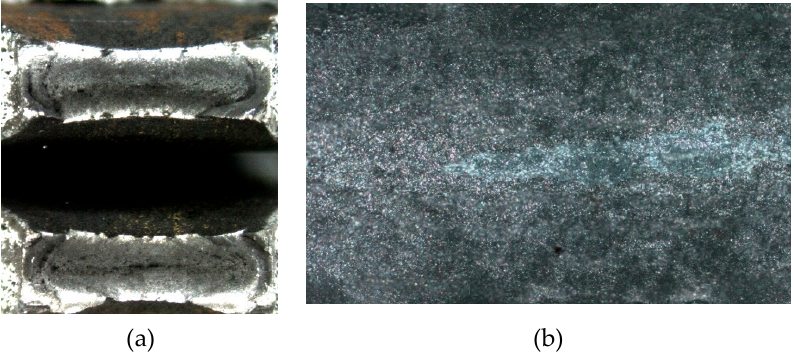
Figure 9. Fracture cup-cone area ( a ). Fracture surface with NIKON EPIPHOT 200 ( b ).